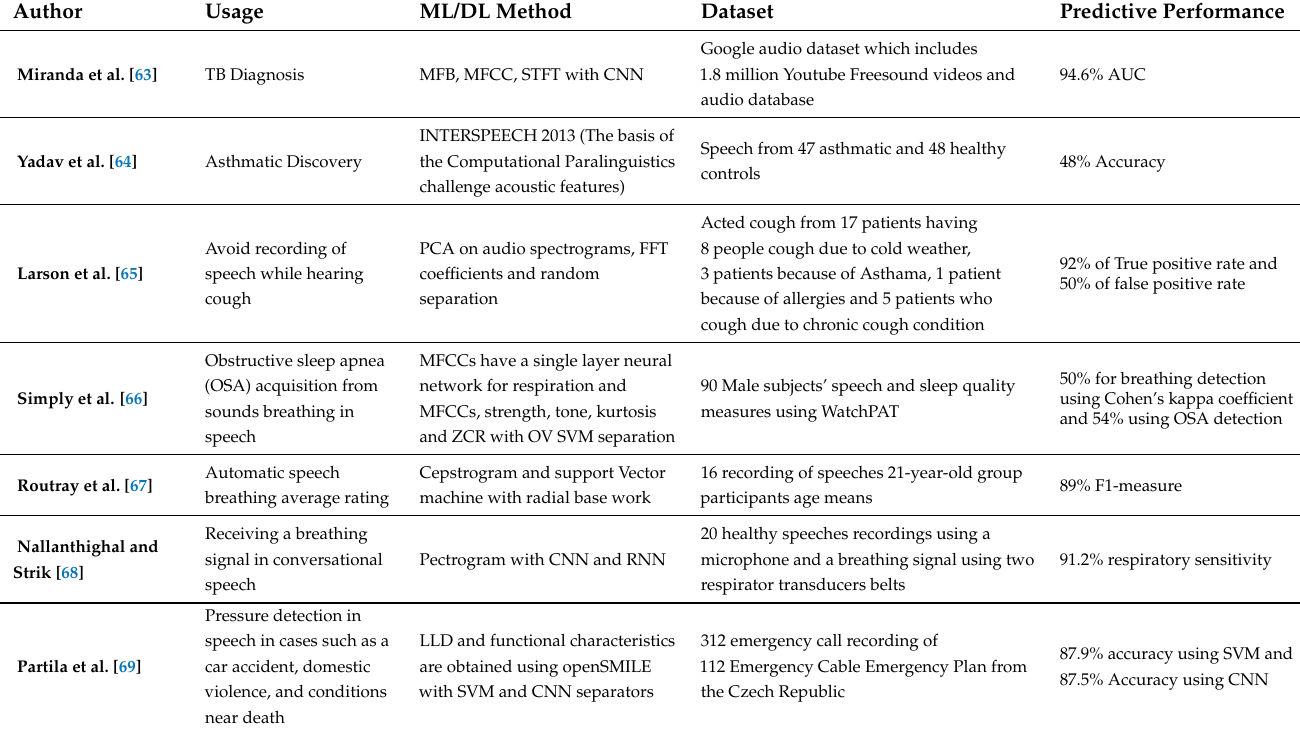
Table 3. An overview of AI-based ML and DL methods for COVID-19 speech and audio